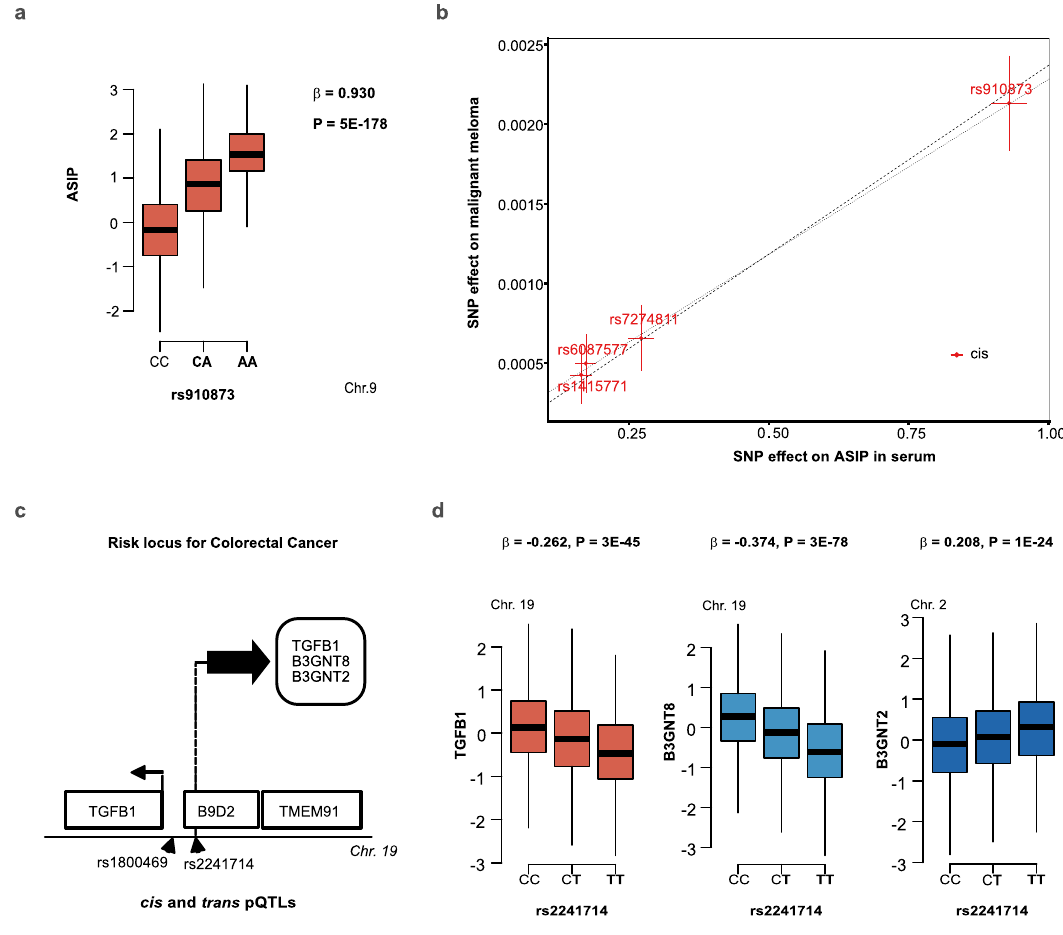
Fig. 6 Proteins associated with malignant melanoma and colorectal cancer. a The melanoma risk allele A (highlighted in bold) for the variant rs910873 is associated with high serum levels of ASIP. The x -axis of the box plot shows the genotypes for the protein-associated SNP, while the y -axis denotes the Box – Cox transformed, age, and sex-adjusted serum protein levels. Box plots indicate median (middle line), 25th, 75th percentile (box), and 5th and 95th percentile (whiskers). The P -value (two-sided) shown at the top of the plot is from linear regression analysis. b Scatterplot for the ASIP protein supported as having a causal effect on malignant melanoma in a two-sample MR analysis. The fi gure demonstrates the estimated effects of the respective genetic instruments on the serum ASIP levels in AGES-RS ( x -axis) and risk of melanoma in GWAS by UK biobank data (UKB-b-12915) 67 ( y -axis), that included 3598 melanoma cases and 459,335 controls. Each center data point displays the estimated effect as beta coef fi cient = log(odds ratio), along with 95% con fi dence intervals for the SNP effect on disease (vertical lines) or SNP effect on the protein (horizontal lines). The broken line indicates the inverse variance weighted causal estimate ( β = 0.0024, SE = 0.0003, P = 1.1 × 10 − 17 , two-sided), while the dotted line shows the MR-Egger regression (see Supplementary Data 5). c The pQTL rs2241714 is a proxy for colorectal cancer-associated variant rs1800469 ( r 2 = 0.978) (Supplementary Data 2), located within the gene B9D2 and proximal to TMEM91 which is the reported candidate gene at this locus (see Table 1). The gene encoding TGFB1, a protein linked to rs2241714 in cis , is also nearby. d The variant rs2241714 (and rs1800469) is associated with the serum proteins TGFB1 (in cis ), B3GNT8 (in cis ), and B3GNT2 (in trans ). The P -values (two-sided) shown at the top of each plot are from linear regression analysis. The x -axis of each box plot shows the genotypes for the corresponding protein-associated SNP, while the y -axis denotes the Box – Cox transformed, age, and sex-adjusted serum protein levels. Box plots indicate median (middle line), 25th, 75th percentile (box), and 5th and 95th percentile (whiskers). The chromosomes indicated at the top of each graph correspond to the location of the gene that encodes the protein of